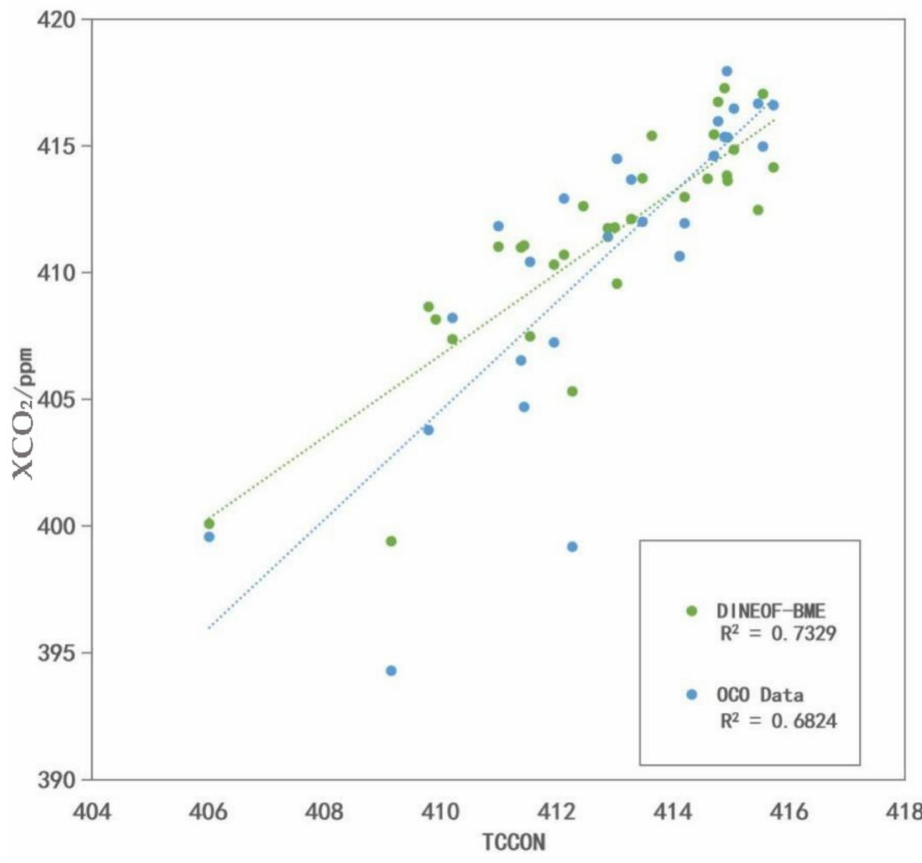
Figure 7. Scatter diagram of the TCCON XCO 2 Measured Data Compared with the OCO XCO 2 Data and the Product of XCO 2 interpolated by the synthetic DINEOF–BME